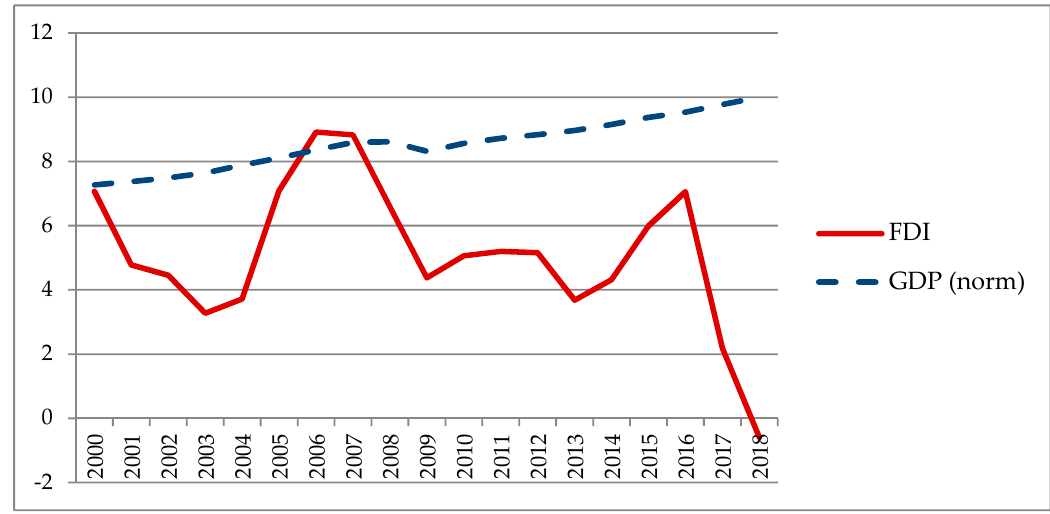
Figure 1. Variability of GDP and foreign direct investment means. Source: authors’ presentation.